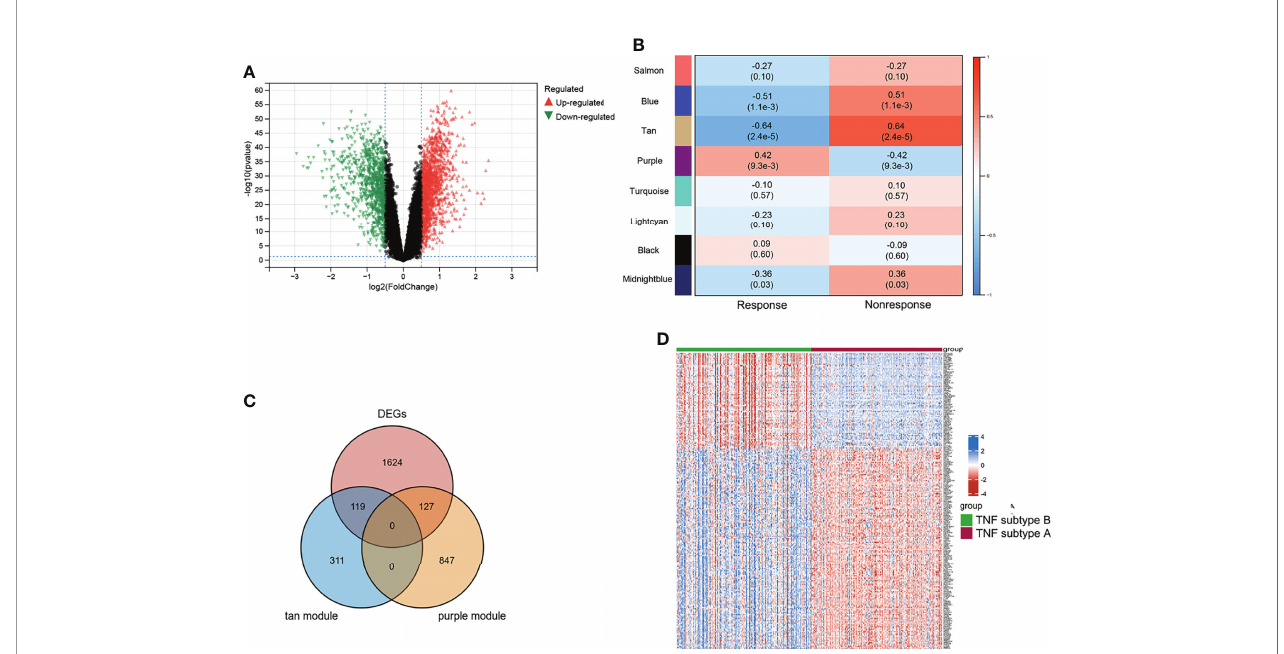
FIGURE 3 | Characteristic of TNF subtypes. (A) Volcano plot of DEGs between two TNF subtypes. (B) WGCNA module trait relationships in response and non- response, which contained the corresponding correlation and p-value. (C) Intersection of DEGs and response-related genes. (D) Heatmap of response-related DEGs; blue and red represent upregulated and downregulated expression,